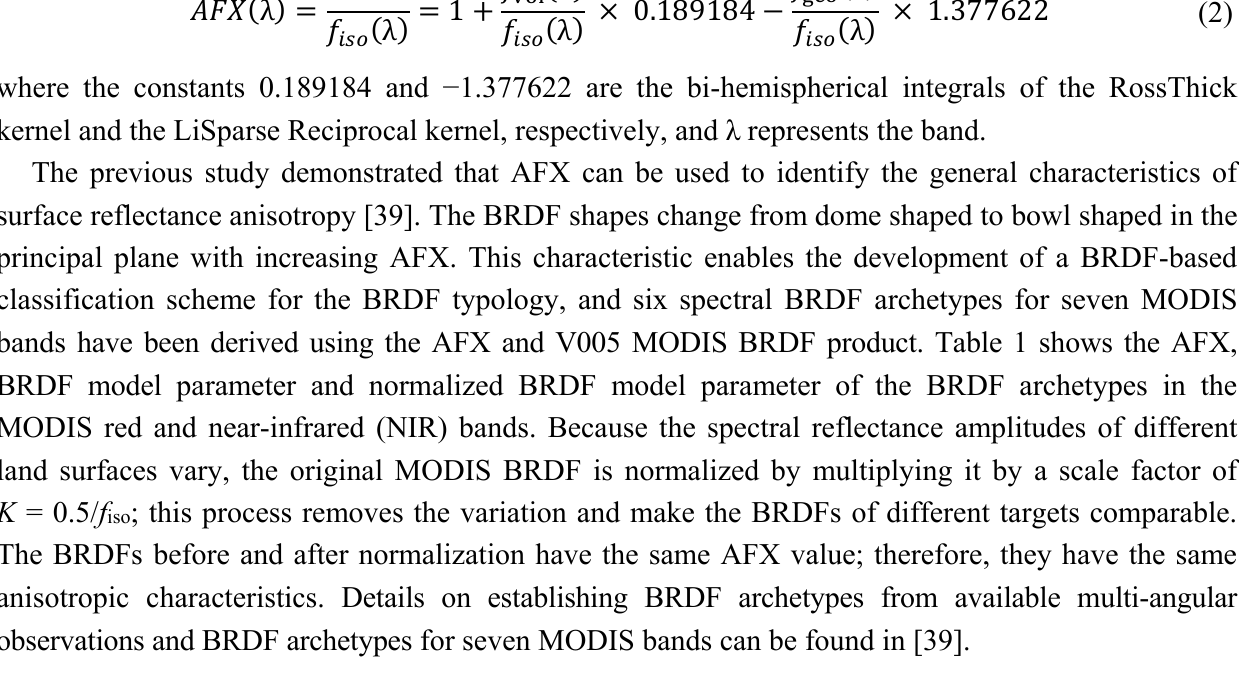
Table 1. AFX and model parameters of six BRDF archetypes in the original ( f and normalized ( F